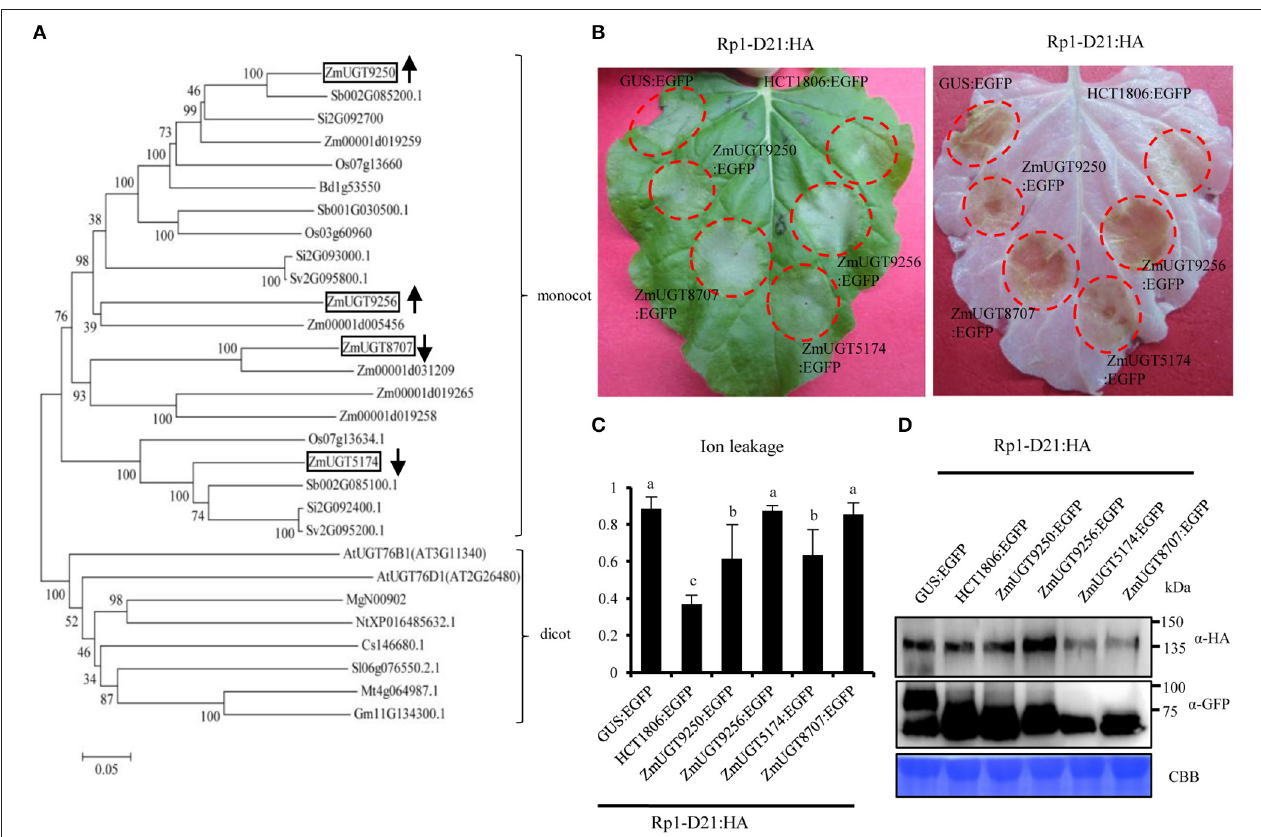
FIGURE 7 | Phylogenetic analysis of UDP-glucuronosyltransferase (UGT) proteins and the function of ZmUDP-glucuronosyltransferases (UGTs) in Rp1-D21-mediated hypersensitive response (HR). (A) The phylogenetic tree was constructed using MEGA 6.0 software. At, Arabidopsis thaliana ; Bd, Brachypodiumdistachyon ; Cs, Cucumissativus ; Gm, Glycine max ; Mg, Mimulusguttatus ; Mt, Medicagotruncatula ; Nt, Nicotianatabacum ; Os, Oryza sativa ; Sb, Sorghum bicolor ; Si, Setaria italica ; Sl, Solanum lycopersicum ; Sv, Setaria viridis ; Zm, Zea mays . The boxes indicate the UGT homologs of maize which were differentially expressed in Rp1-D21 . (B) ZmUGTs were transiently co-expressed with Rp1-D21 into Nicotiana benthamiana . The representative leaf was photographed at 3 days after inoculation (left), and the same leaf was cleared by ethanol (right). (C) Ion leakage conductivity [average ± standard error (SE), n > 5] was measured at 60h after co-expression of GUS, HCT1806, or ZmUGTs with Rp1-D21. Significant differences ( p < 0.05) between samples are indicated by different letters (a–c). (D) Total protein was extracted from agro-infiltrated leaves at 40 hour post inoculation (hpi). Anti-HA was used to detect the expression of Rp1-D21, and anti-GFP was used to detect the expression of GUS, HCT1806, and ZmUGTs. Equal loading of protein samples was shown by Coomassie brilliant blue (CBB) staining. The experiments were performed three times with similar